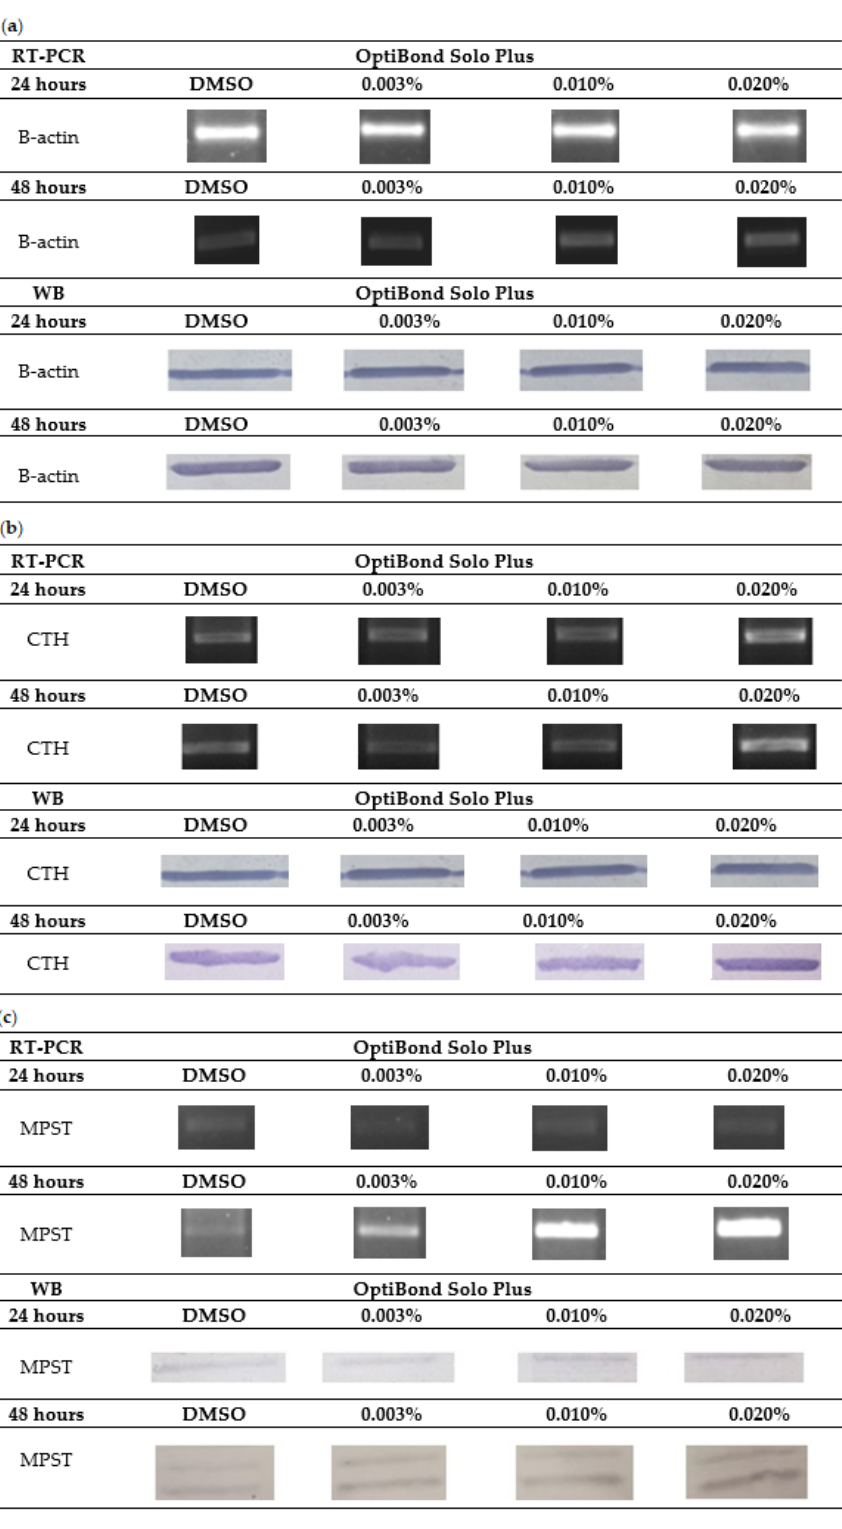
Figure 3. Expression of ( a ) β -actin, ( b ) CTH, and ( c ) MPST in Hs27 fibroblast cells after 24- and 48-h incubations with OptiBond Solo Plus by RT-PCR and Western blot (WB). The tested concentrations of OptiBond Solo Plus in culture medium as listed: 0.003, 0.010, and 0.02 with 0.1% DMSO treated cells as a control. The experiment was repeated at least two times and the WB and the RT-PCR was run two times for the samples from each experiment with similar results. A representative result is